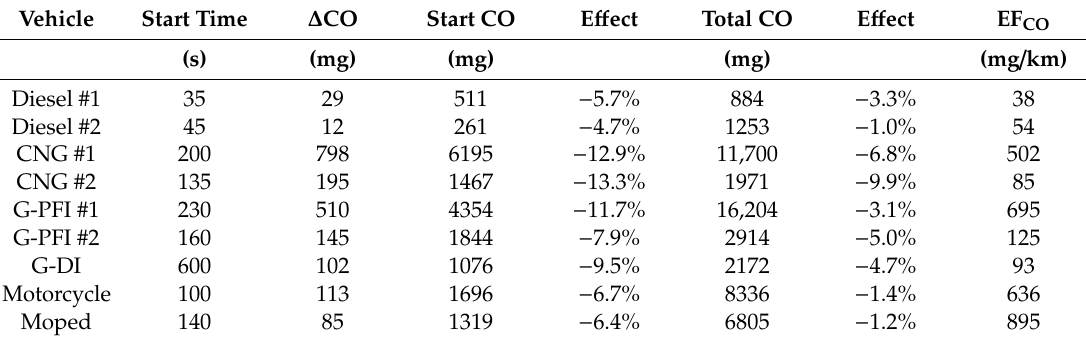
Table 6. E ff ect of condensation on CO mass emissions for the beginning of the cycle and the full cycle (WLTC or WMTC for two-wheelers). “ ∆ CO” stands for the di ff erence between the CO mass emissions calculated using the K d-w,RDE and the K d-w,H 2 O for the start duration of the cycle given in column